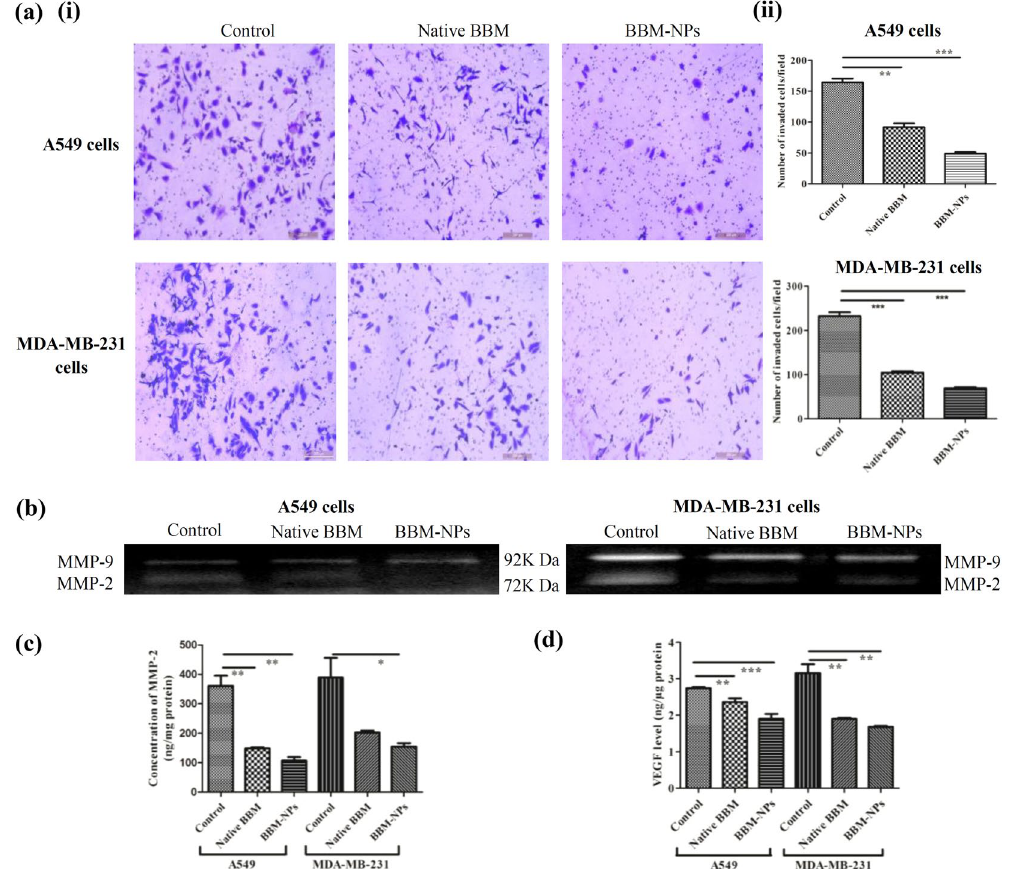
cells were harvested and 1 × 10 5 live cells seeded in the upper chamber of a matrigel-coated transwell plate and invasion assay was studied by microscopy staining with crystal violet after 24 hrs. (i) Microscopic picture of invaded cells. (ii) Bar graph represents the number of cells invaded the matrigel. Values are as mean ± SEM, n = 3, ** p < 0.001, *** p < 0.0001 for Native BBM and BBM-NPs vs. control. During invasion assay, the left over supernatants on the upper chamber of transwell insert was collected from all the treatments of both the cells. ( b ) Inhibition of pro-matrix MMP-9/MMP-2 activation by gelatin zymography ( c ) MMP-2 level measured by ELISA Kit. Values are as mean ± SEM, n = 3, * p < 0.05, ** p < 0.005 vs. control. (d) The secreted VEGF in